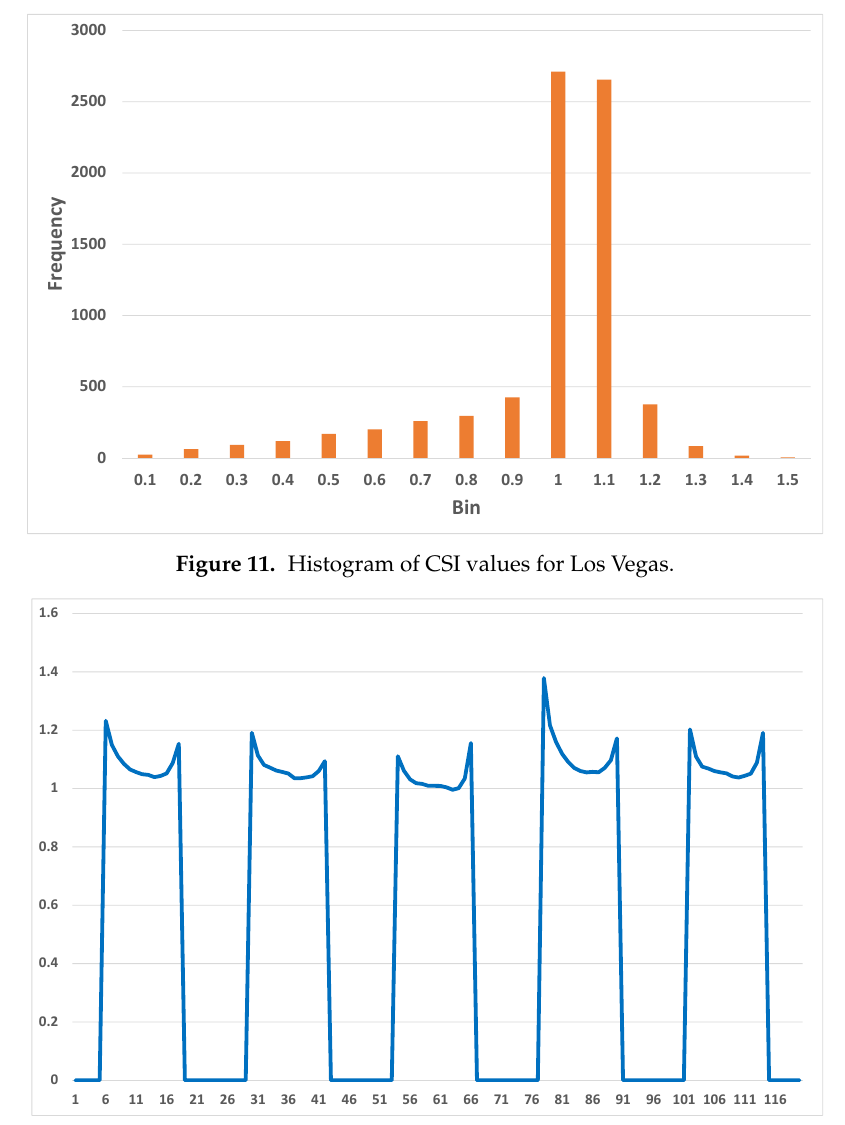
Figure 12. Five days of CSI for Los